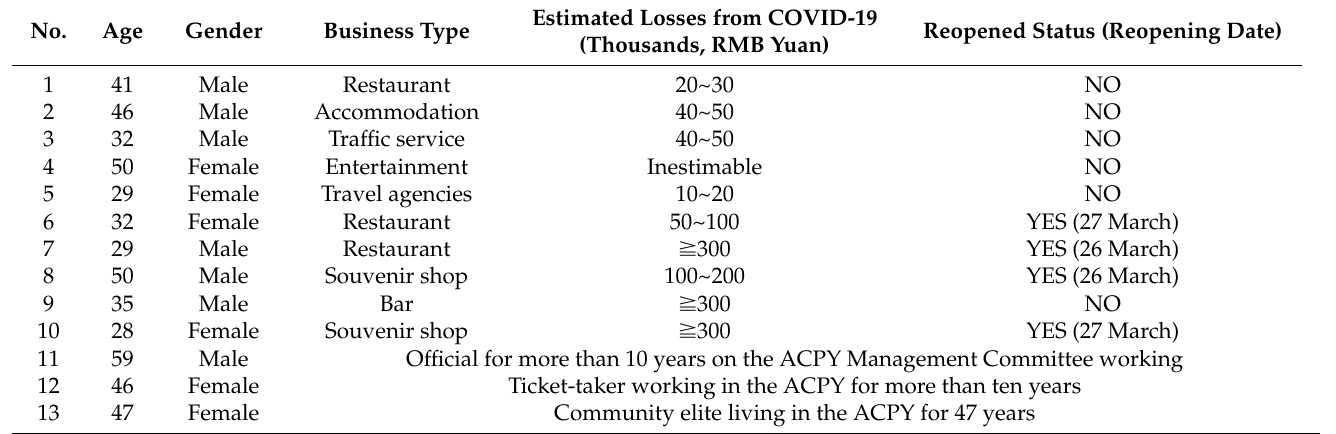
Table 1. Interview participant profiles.